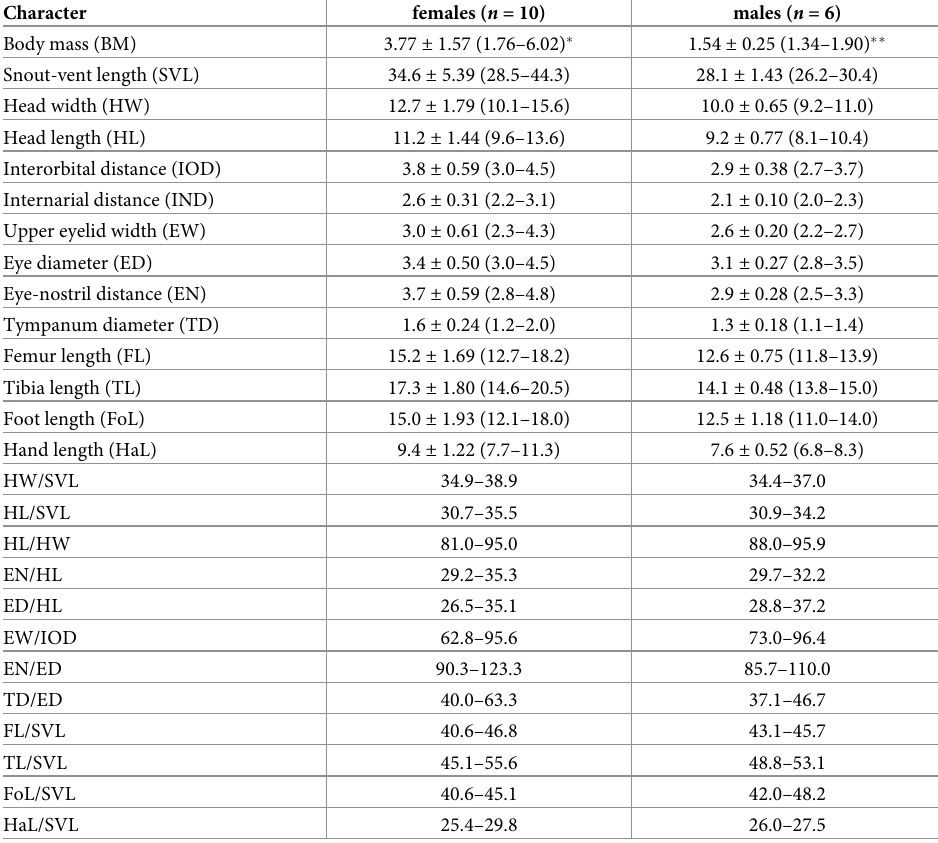
Table 1. Body mass (in grams), measurements (in mm) and morphological proportions (in percentages) of adult females and males of Pristimantis lojanus sp.